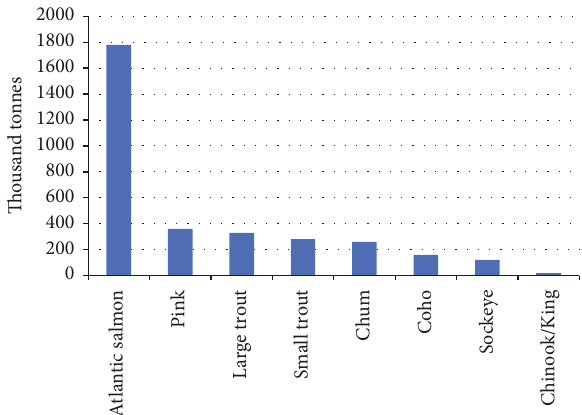
Figure 1: 2012 Worldwide Salmonids Harvest (species).